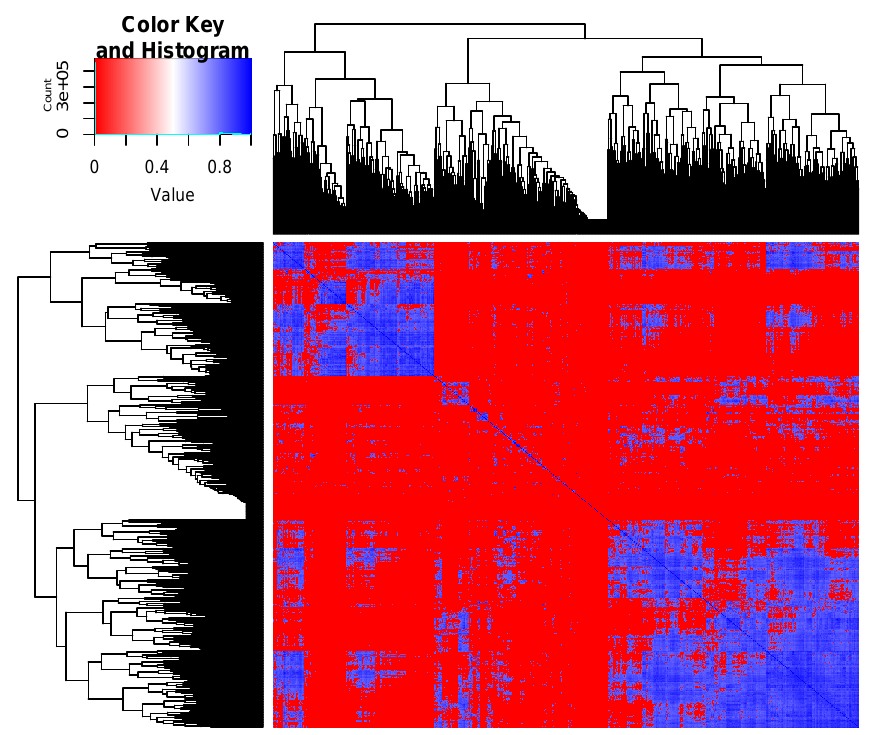
Figure 4. Visualization of the correlation matrix after hierarchical clustering using complete linkage method with euclidean